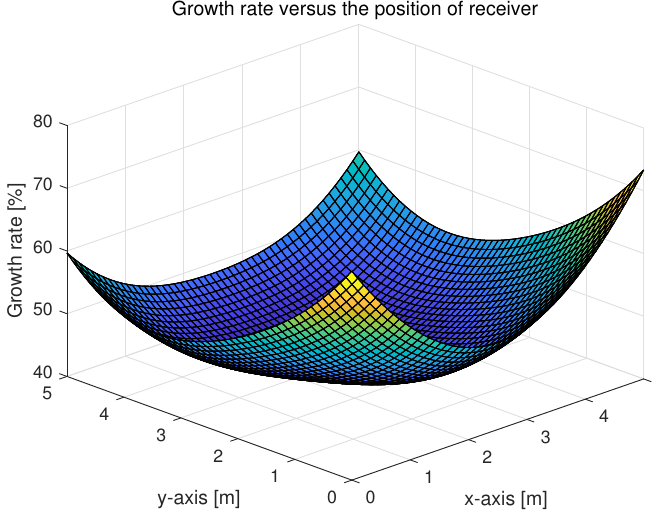
Figure 7. Growth rate versus the position of